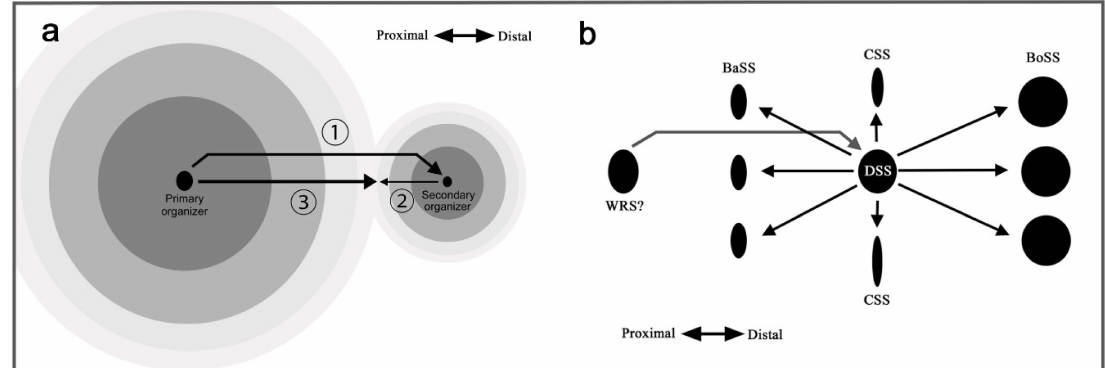
Figure 11. Possible mechanism that results in the distal elaboration rule. ( a ) Signal propagation from the primary organizer induces the secondary organizer (1). The secondary organizer produces the signal into both the distal and proximal sides (2). Only the signal that is propagating proximally collides with the signal from the primary organizer (3). This results in symmetry breaking of system’s structure, but not its relative color positioning. ( b ) Possible developmental relationships among system organizers. To realize the distal elaboration rule in the wing-wide supersymmetry system (i.e., BoSS is more elaborated than the BaSS), an upstream organizer should be located proximally, which may be located in or close to the thorax. The wing root band system may be qualified for this function. For abbreviations, see Figure